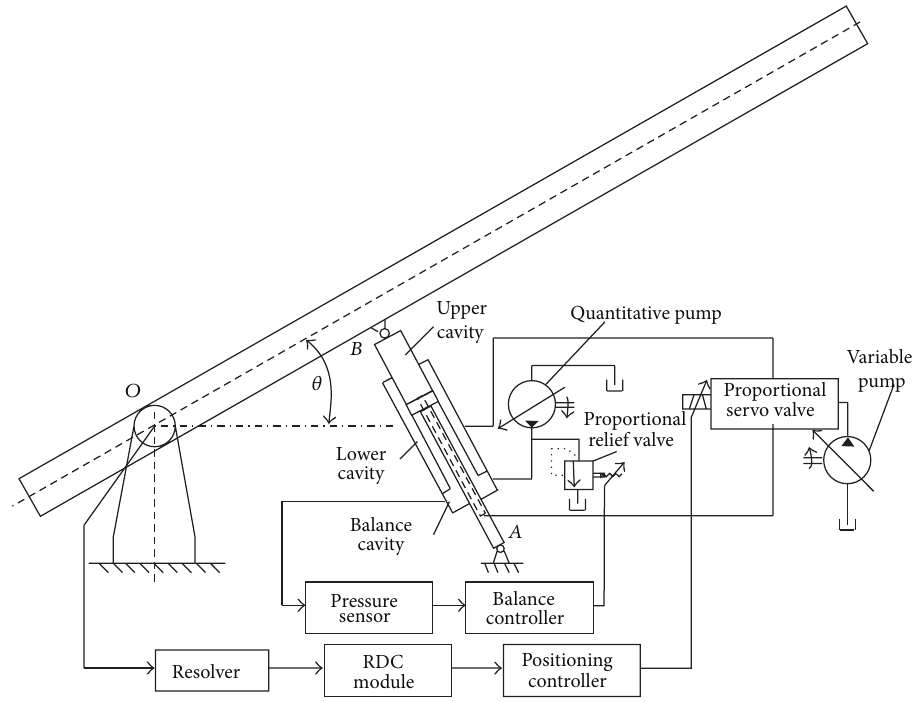
Figure 1: Schematic of the isoactuation EHS